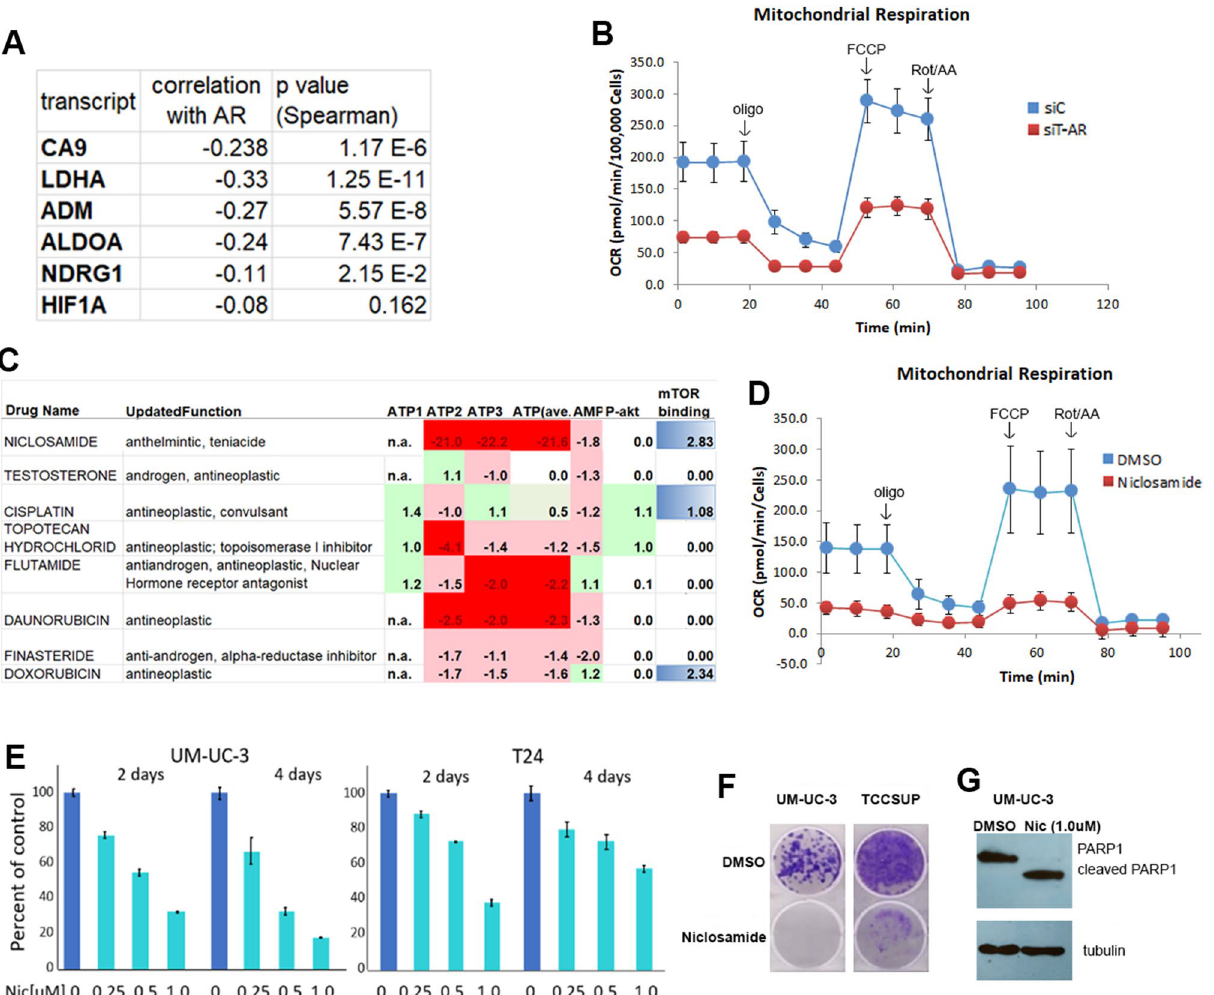
Figure 7. HIF1A components and hypoxia levels inversely correlate with AR expression in high grade BlCa malignancies. ( A ) Interrogation of high grade BlCa malignancies (TCGA 2017) identified statistically significant negative correlations between expression of AR and multiple HIF1A pathway components. ( B ) OCR decrease on total AR depletion is indicative of compromised mitochondrial function. ( C ) An analysis of 1600 agents revealed that niclosamide is a very potent inhibitor of ATPase. The analysis was in triplicate (labeled 1, 2 3) and values were averaged. AMP kinase (AMPK) activity, phospho-ATK (P-AKT) levels and mTOR binding was evaluated. ( D ) OCR decrease on niclosamide treatment is indicative of compromised mitochondrial function. ( E ) Niclosamide treatment decreased cell viability in a time and dose dependent manner in two BlCa cell lines. ( F ) Colony formation assays confirmed the potent effects of niclosamide (0.5uM) following a 10-day treatment in two cellular contexts. G. Complete PARP1 cleavage on niclosamide treatment is indicative of an apoptotic response. Blue- binding. Immunoblots were cropped prior to incubation with specific